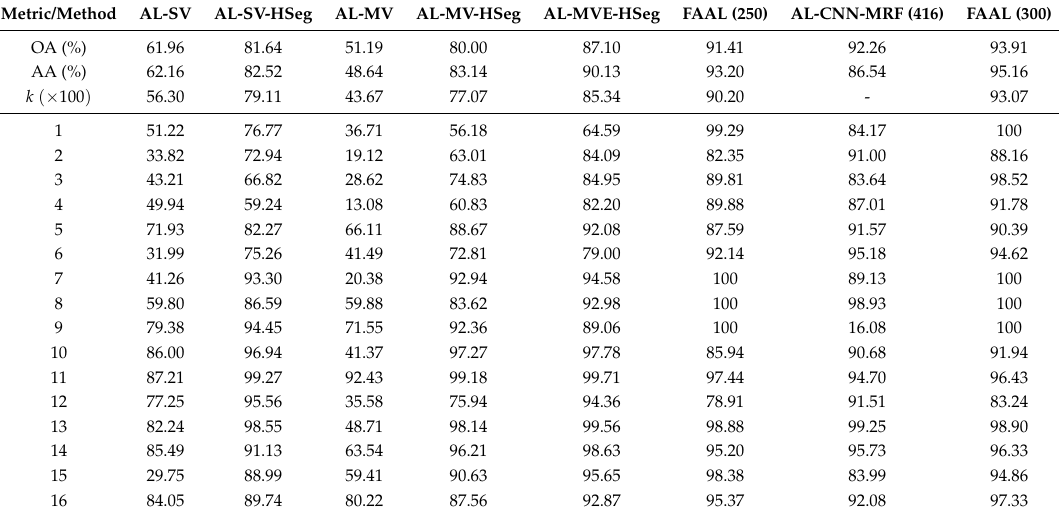
Table 5. Comparison of active classifiers and FAAL on Indian